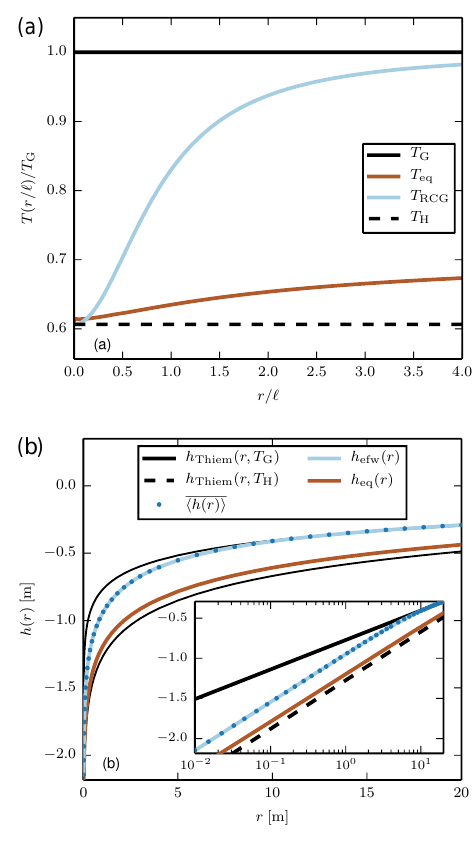
Figure 1. Comparison of equivalent and radial coarse graining approach: (a) radially dependent transmissivities interpolating be- tween harmonic mean T H and geometric mean T G : T RCG (r) from Eq. (4) and T eq (r) calculated based on Thiem’s formula Eq. (1) with h(r) = (cid:104) h(r) (cid:105) , which is the ensemble mean for ensemble A (Ta- ble 1); (b) hydraulic head drawdowns after pumping with h efw (r) from Eq. (6) as a solution of the well flow equation using T RCG (r) , h eq (r) as a solution of the well flow equation using T eq (r) , Thiem’s solution with constant values T G and T H , and mean ensemble draw- down (cid:104) h(r) (cid:105)